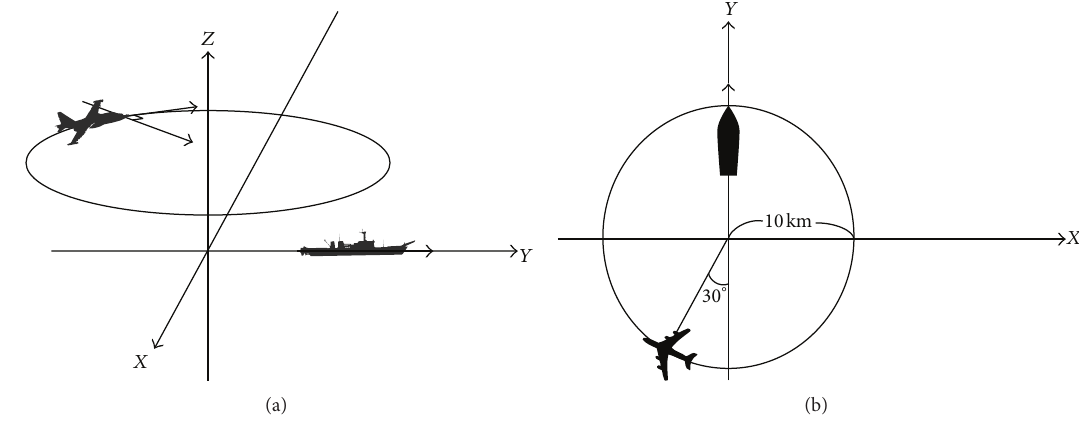
Figure 11: Simulation scenarios of Case 3 for (a) 3D and (b) top view